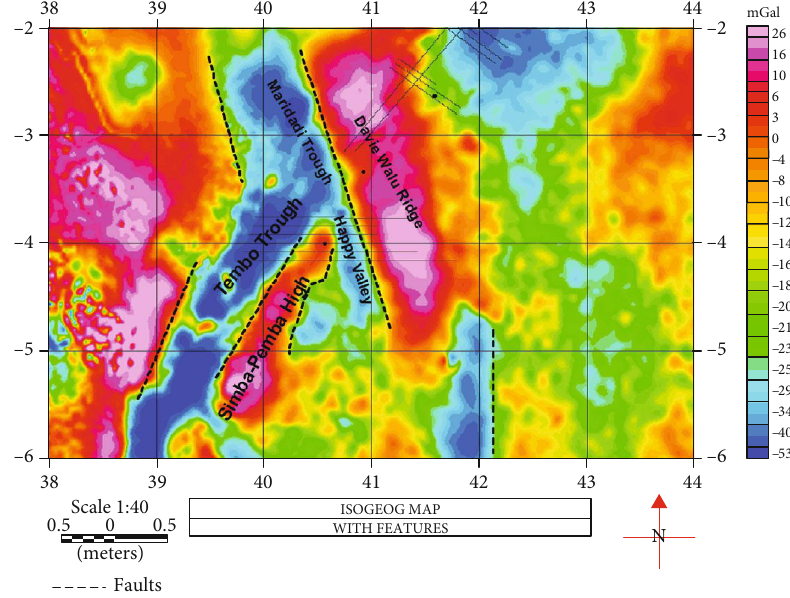
Figure 4: Regional map with the main features indicated and labelled.